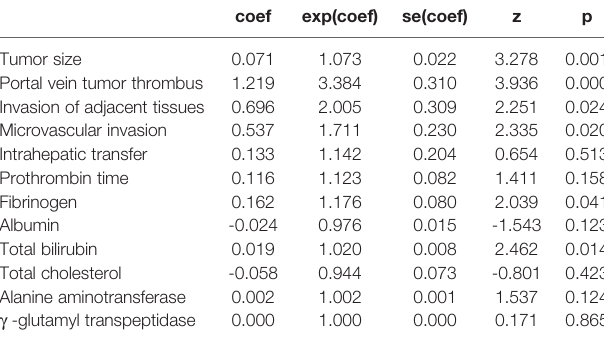
TABLE 3 | Multivariate analysis of the training